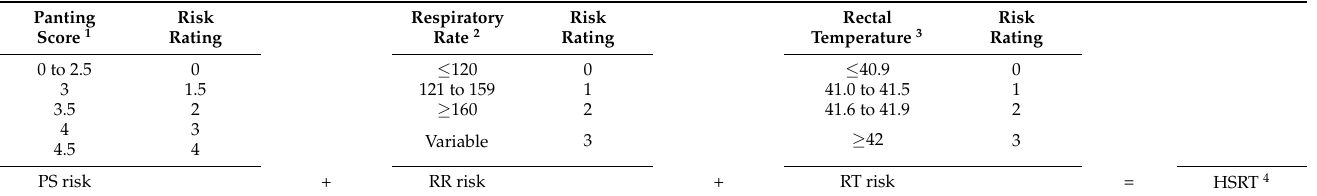
Table 3. Calculating the heat-stress risk total of individual cows housed in controlled-climate cham- bers under hot conditions by rating risk of thermal stress measured by observations of panting score, respiration rate, and rectal